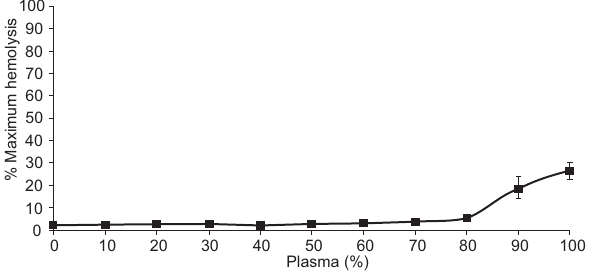
Figure 1. Concentration-dependent hemolysis of SRBCs by fresh- water turtle P. geoffroanus . SRBCs were incubated with different concentrations of the plasma from P. geoffroanus for 60